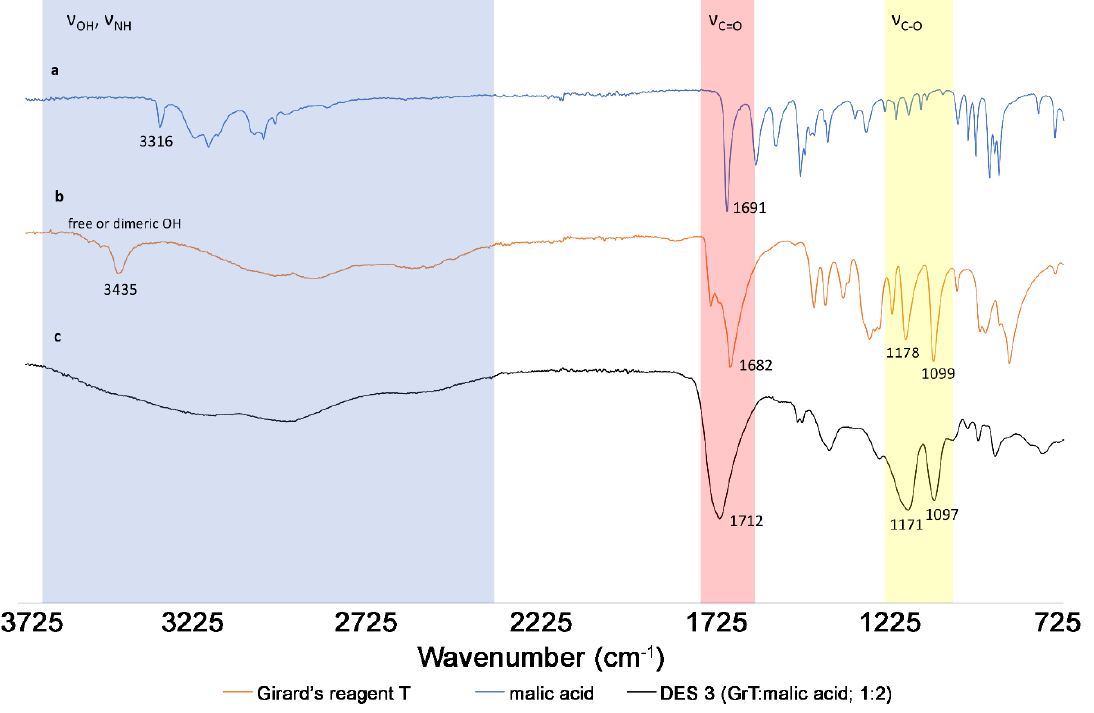
Figure 2. Changes in FT-IR spectra of free components ( a ) Girard’s reagent, ( b ) malic acid and ( c ) the formed DES-3 (GrT:malic acid, 1:2).